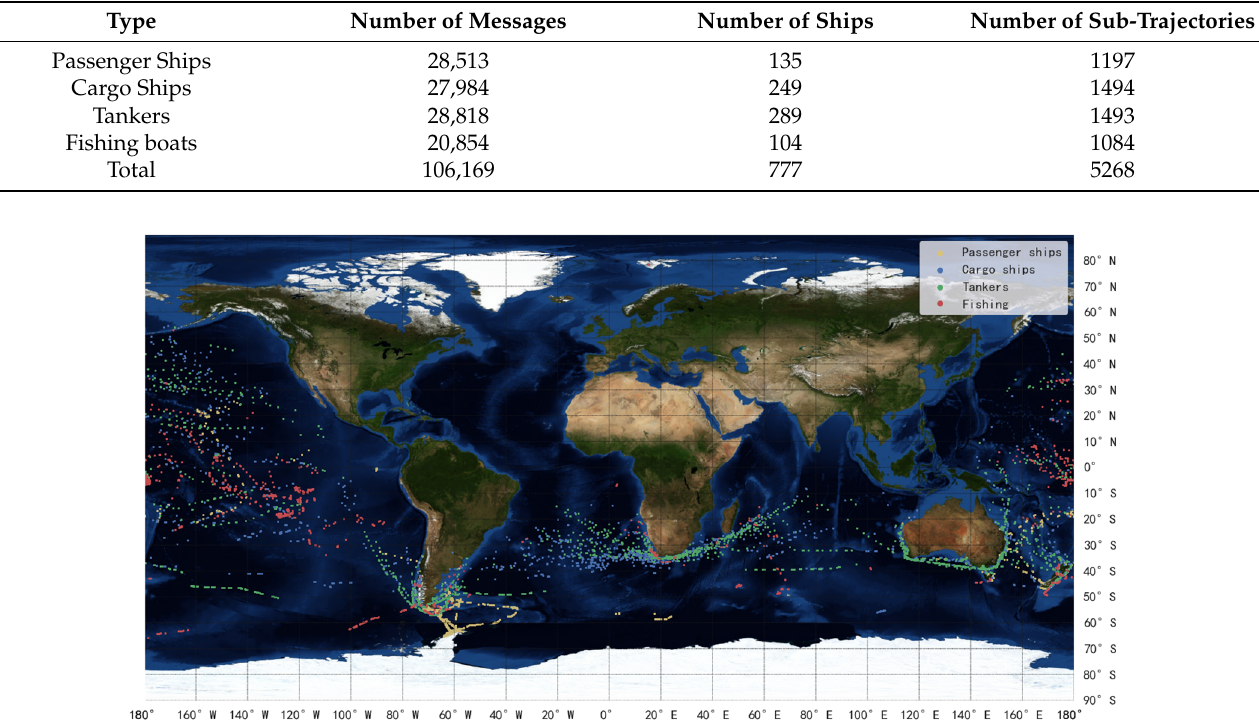
Figure 25. Ships distribution of dataset M. Table 11. The amount of data in dataset M.